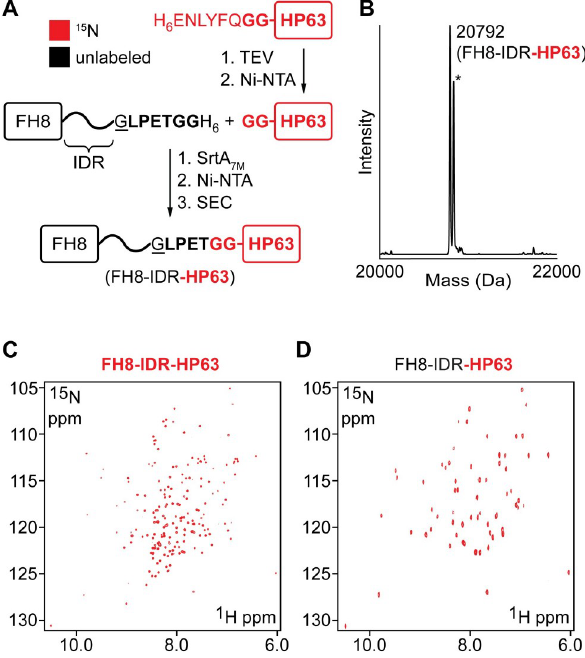
Fig 4. Segmental isotopic labeling of truncated villin 4. ( A ) SML strategy for producing segmentally labeled derivatives containing an IDR segment (35-residue acidic fragment) and the headpiece domain of villin 4. ( B ) ESI-MS spectrum of purified FH8-IDR-HP63 with selective incorporation of 15 N in the HP63 segment (calculated MW assuming 100% 15 N incorporation in HP63 = 20797 Da, � = MeCN adducts from LC-ESI-MS mobile phase). ( C ) 15 N-HSQC (500 MHz, 25˚C) of uniformly labeled FH8-IDR-HP63. Based on the sequence of FH8-IDR-HP63, 176 resonances originating from non-proline residues are expected and 173 were observed. ( D ) 15 N-HSQC (500 MHz, 25˚C) of segmentally labeled FH8-IDR-HP63 in which 15 N labeling is restricted to HP63. Based on the sequence of the labeled segment, 61 resonances originating from non-proline residues are expected and 58 were observed.